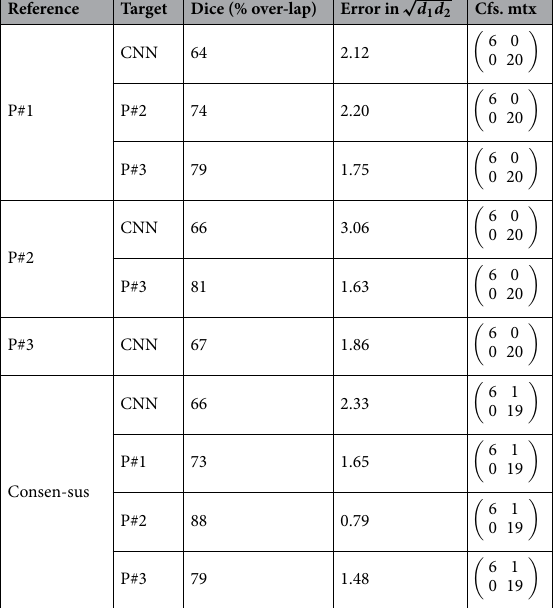
Table 7. Comparison between references (expert pathologists), and our method on slide-level tasks using the EfficientNet-B3 architecture, including the consensus ground truth (with 8% of the dataset removed). P#* indicates the expert ID, and CNN is the trained network to segment the tumor bed automatically. In all experiments, we use K-means negative sampling, 256 as the tile stride, and color jittering and affine transformations as data augmentation.